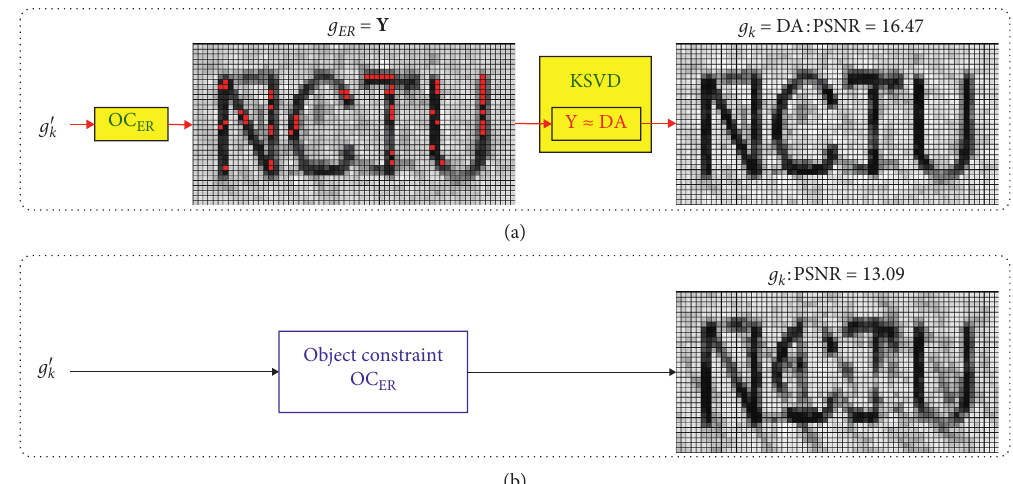
Figure 5: Final estimated object g k at a certain iteration. (a) Our proposed method. The red pixels in . (b) Classical ER method. Here, the same initial Fourier phases are given and the activation OC are generated from the activation OC ER the object constraints is selected during PR iteration to fairly examine the performance improvement when applying the image inpainting technique. The estimated object g k from our proposed method (ER+KSVD) shows that its peak signal-to-noise ratio (PSNR) is higher than using the classical ER